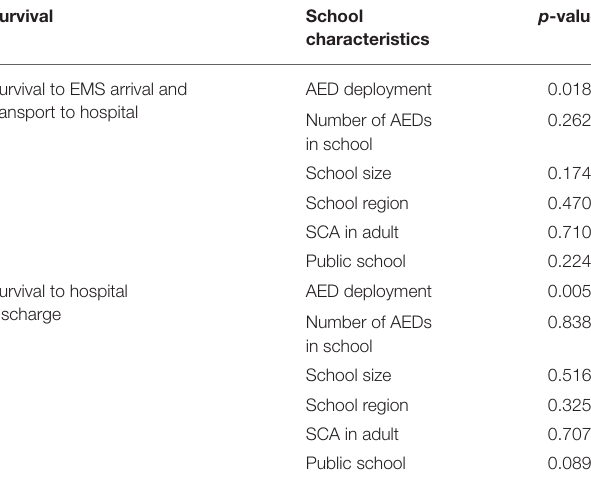
TABLE 3 | Chi-Square associations between SCA survival and AED deployment, patient and school